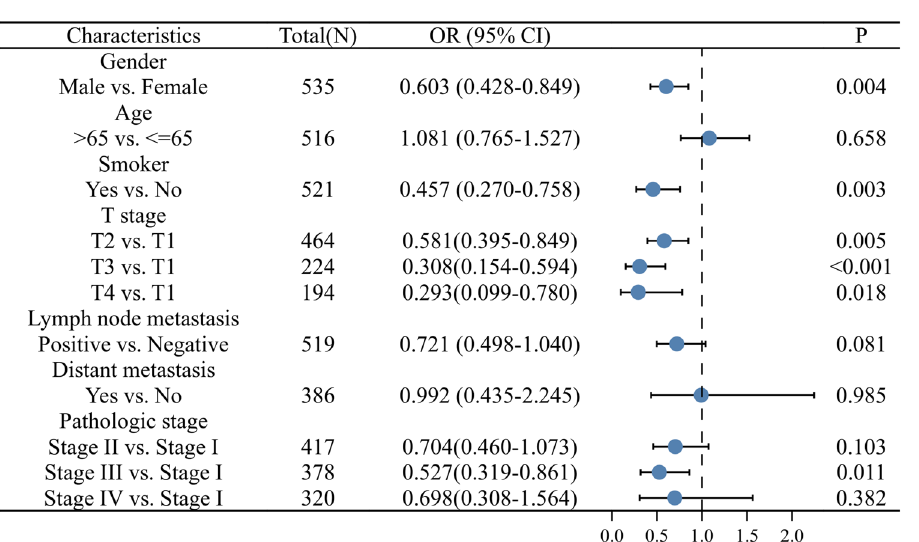
Figure 3. Relationship between ADRB2 and clinical